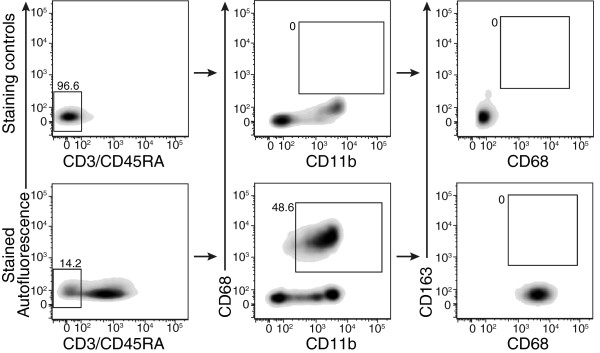
CD68+ blood monocytes do not express CD163. Blood was isolated from uninjured rat. Total white blood cells were collected and submitted to antibody staining for flow cytometric analyses to assess CD163 expression on CD3-CD45RA-CD11b+CD68+ cells. Gates were set using omission of primary antibody for CD3/CD45RA and for CD11b; and using isotype control staining for CD68 and CD163. Results shown are representative of 4 individual observations.